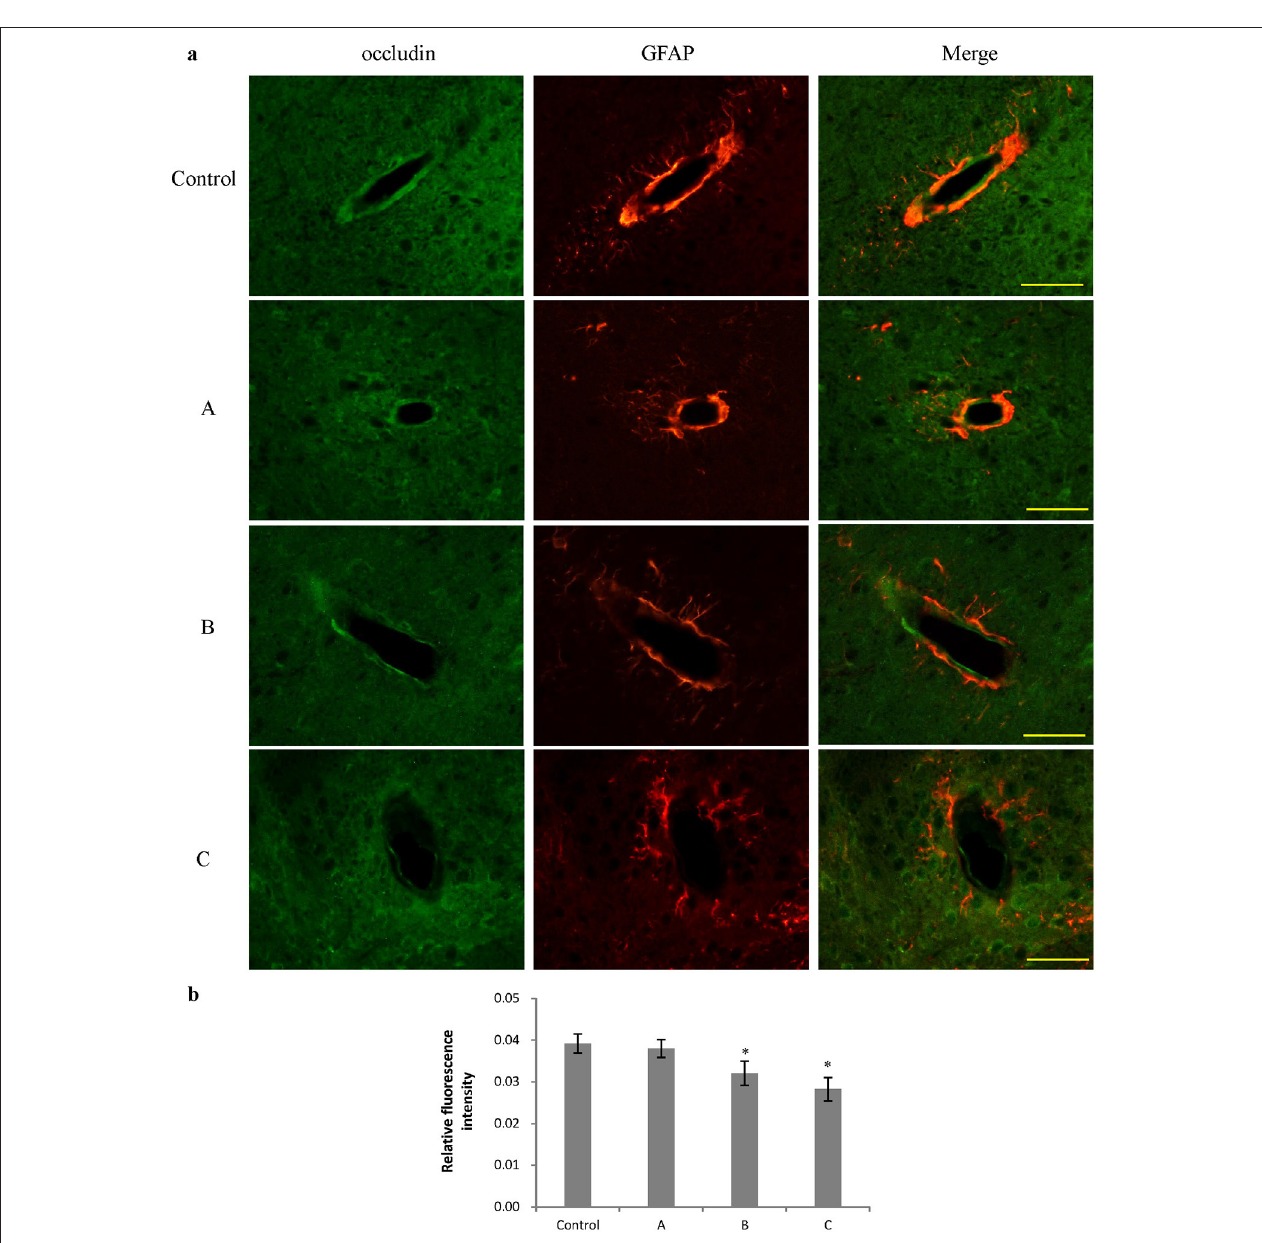
FIGURE 4 | Comparison of occludin protein expression in mouse brain among groups (scale bar = 25 µ m). Five mice were selected in each group. Data were given as mean ± SD , and analyzed by one-way ANOVA. Significant difference was defined as P < 0.05, * vs. control group. (a) Immunofluorescence staining, green represented occludin, and red is for GFAP. A to C represented three exposure groups, in which mice were exposed to 1,2-DCE for 1, 2, or 3 days. (b) Comparison of relative fluorescence intensity for occludin among